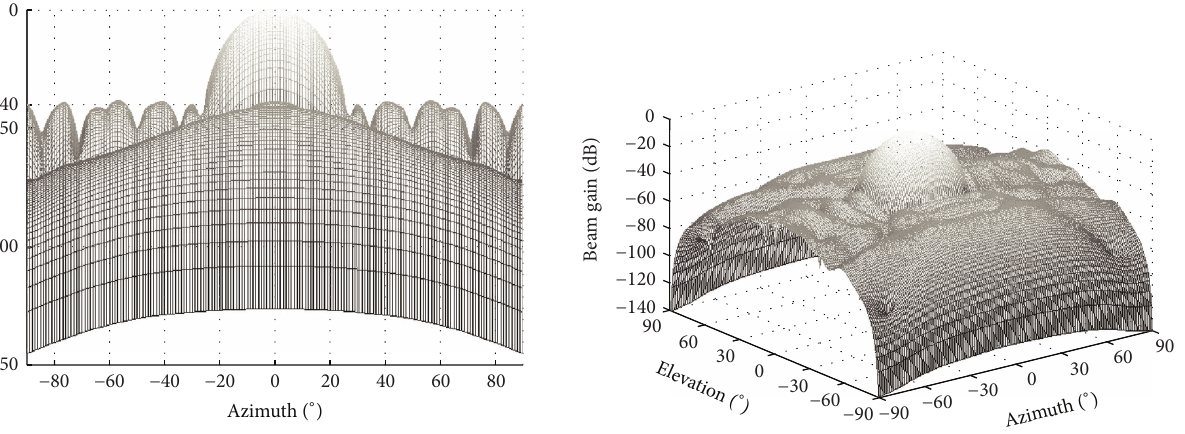
Figure 8: 2D beam pattern for the cylindrical array.